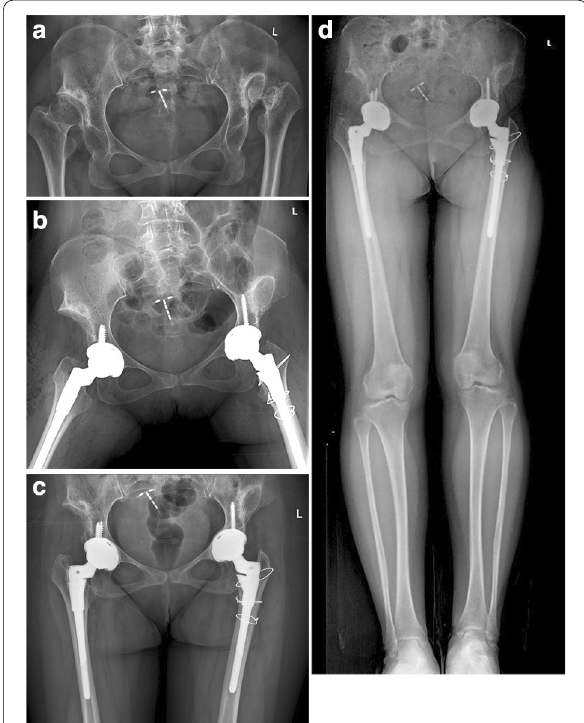
Fig. 5 Preoperative anterior–posterior X-ray showing a bilateral DDH (right hip as Crowe III and left hip as Crowe IV) in a 51-year-old female patient ( a ). Postoperative X-ray showing bilateral anatomical reconstruction ( b ). SSTO was performed in the Crowe IV hip, and the osteotomy length was 2.0 cm. At final follow-up, radiographic evaluation after 1.8 years showing no loosening ( c ). Full-length standing anteroposterior radiograph showing that the right leg was 1.3 cm longer than the left leg ( d